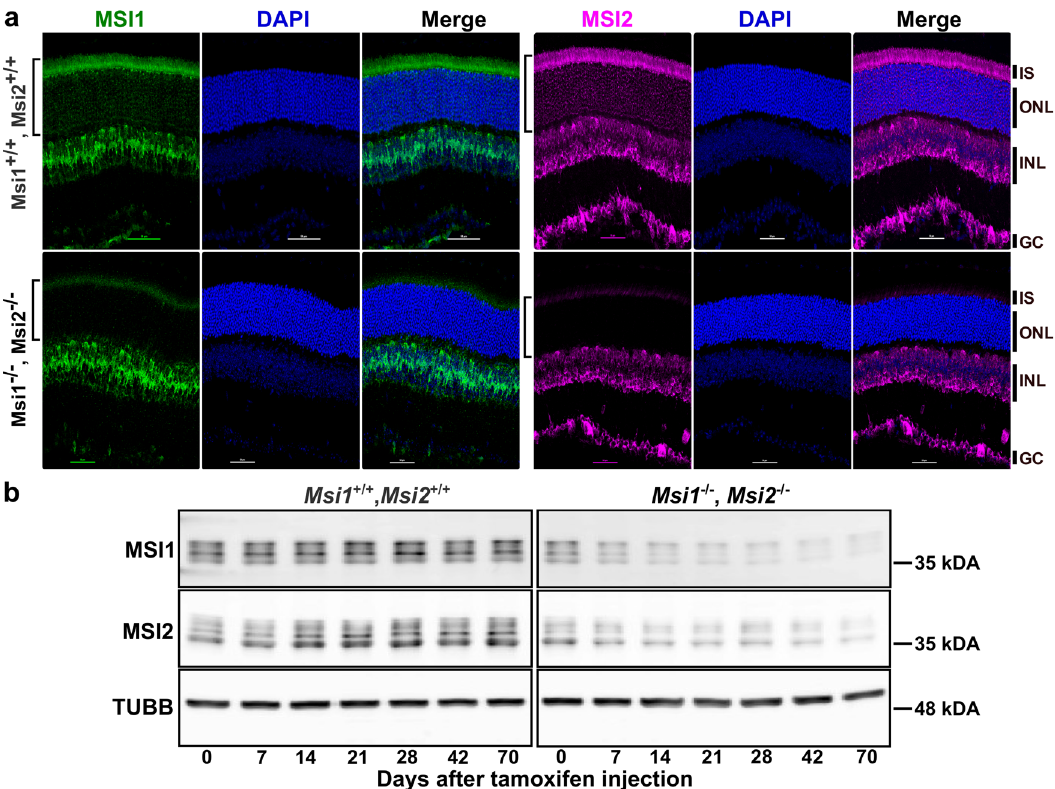
Fig. 1 Induced double knockout of Msi1 and Msi2 in photoreceptor cells. a Immuno fl uorescence micrographs of retinal cross-sections collected 14 days after tamoxifen injection at postnatal day 30 from Msi1 + / + / Msi2 + / + littermate control and Msi1 − / − / Msi2 − / − , stained for MSI1(green), MSI2 (magenta), and DAPI (blue). ONL outer nuclear layer (photoreceptor cell layer). The brackets on the left indicate the layer of photoreceptor cells from which the genes are being deleted. IS: inner segment (photoreceptor cell layer). ONL outer nuclear layer (photoreceptor cell layer), INL inner nuclear layer, GC ganglion cell layer. Objective, 40x. b Immunoblot of lysates from Msi1 + / + / Msi2 + / + and Msi1 − / − / Msi2 − / − retinas collected between 0 and 70 days after tamoxifen injections at postnatal day 30 and probed with antibodies to MSI1, MSI2 and TUBB ( β -tubulin, loading control). Size markers indicate the molecular weight in kDA. See Supplementary Fig. 1 for uncropped